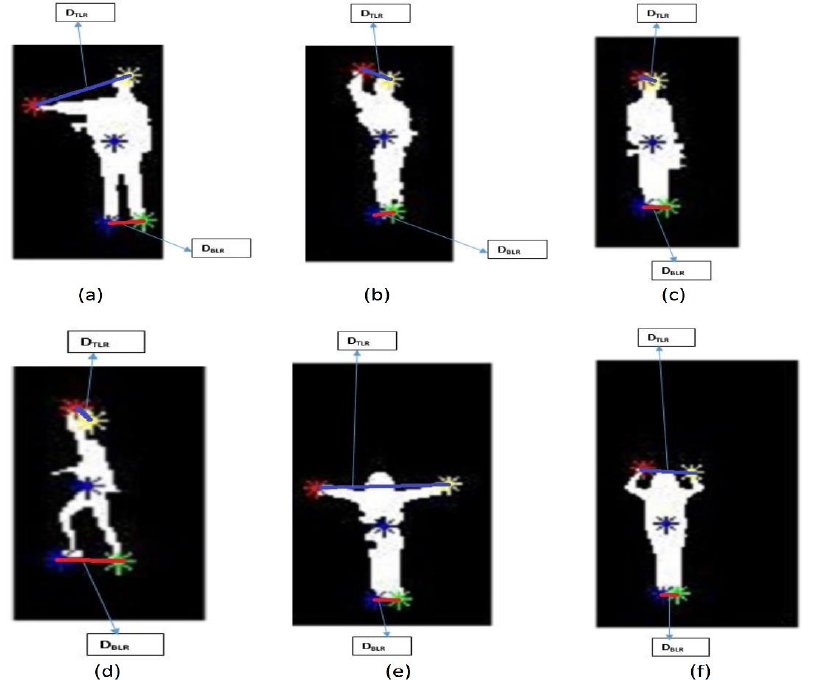
Fig. 2 . Top and Bottom Distances for all the six actions Figure 4. Representing geometric features for human actions. ( a ) single hand side wave; ( b ) single hand top wave; ( c ) standing; ( d ) Walking; ( e ) both hands side wave; ( f ) both hands top Algorithm 2 : Human Height Calculation Algorithm (HHCA)